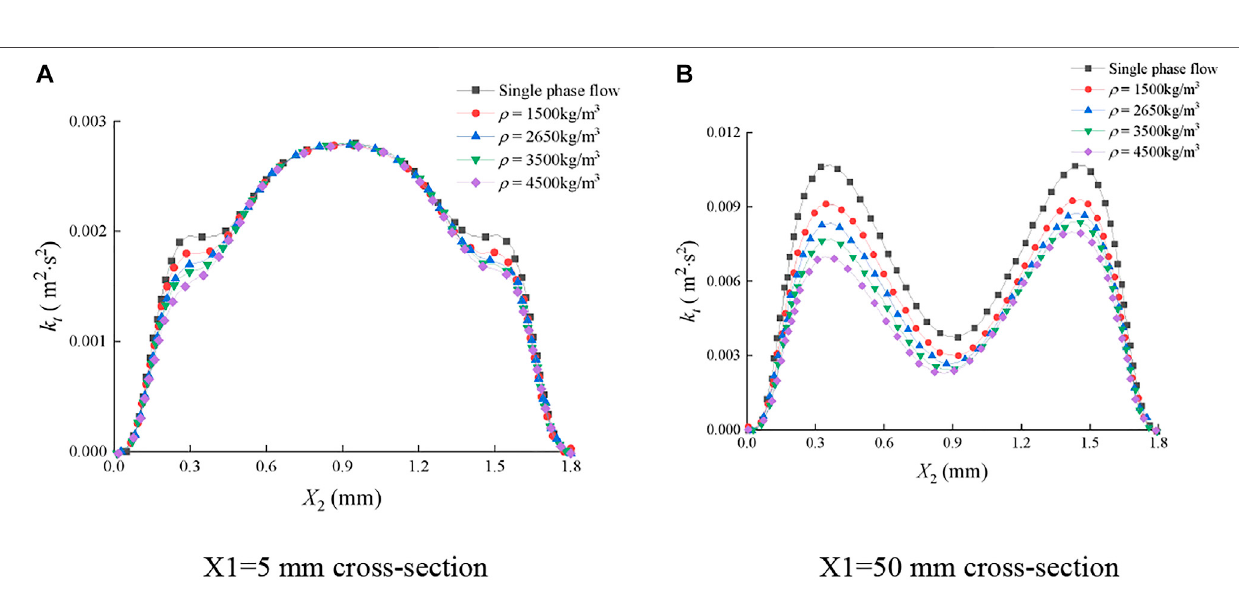
Frontiers in Physics |